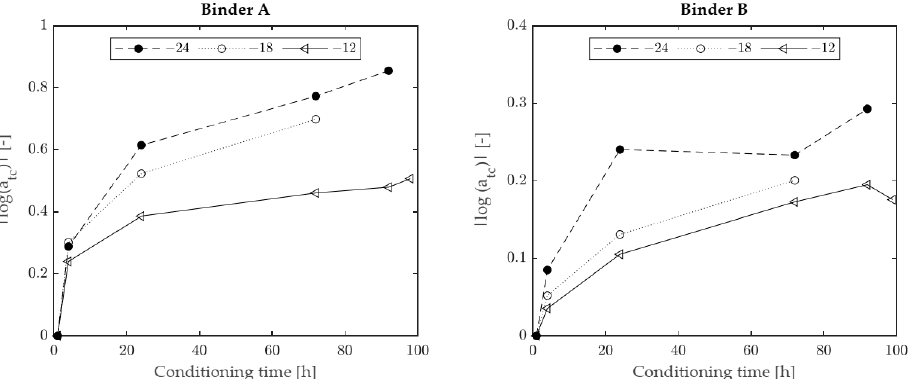
Figure 6. Horizontal shift factors, at different temperatures, as a function of conditioning